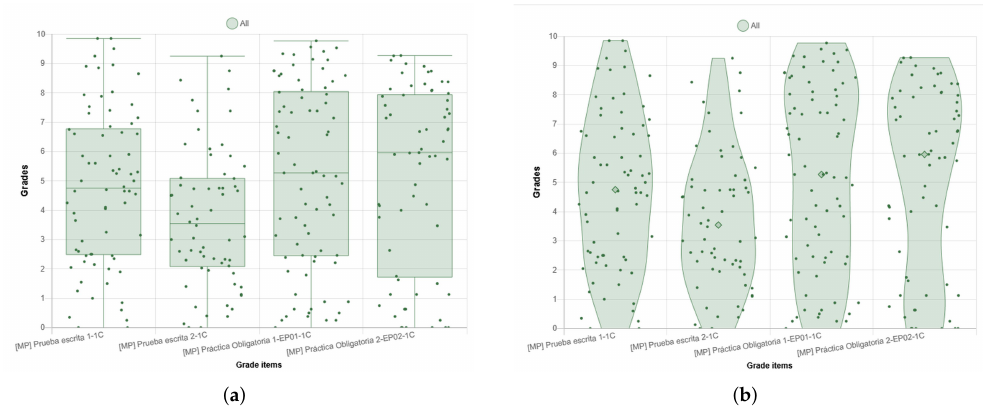
Figure 8. Review of assessable e-learning activities.( a ) Using boxplots. ( b ) Using violin